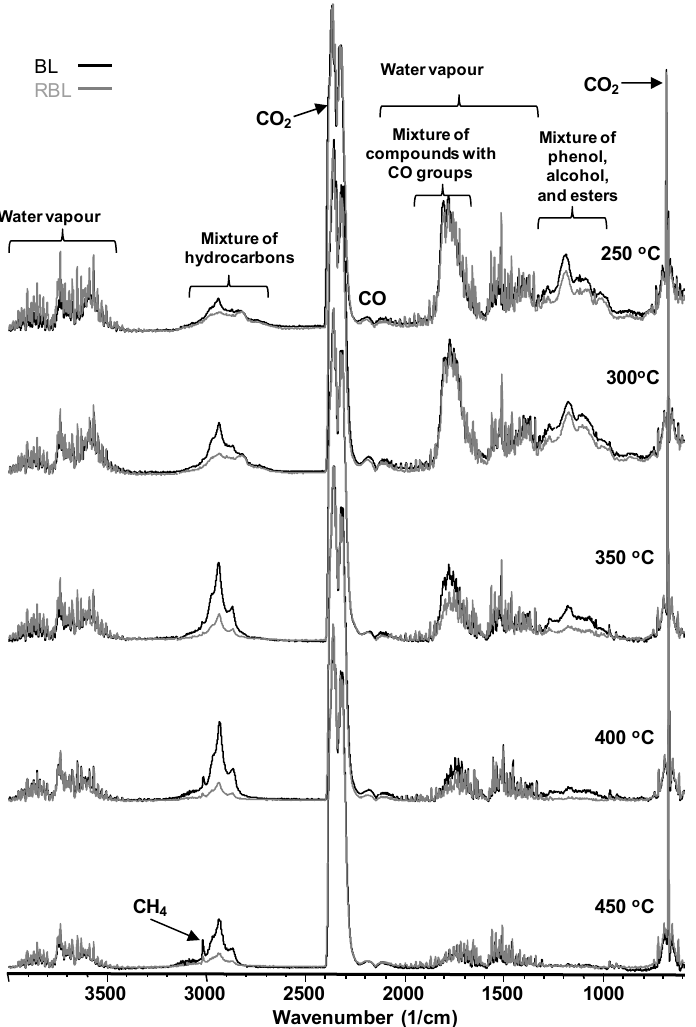
Figure 10. FT-IR spectra of volatile products emitted during pyrolysis of BL and RBL samples.